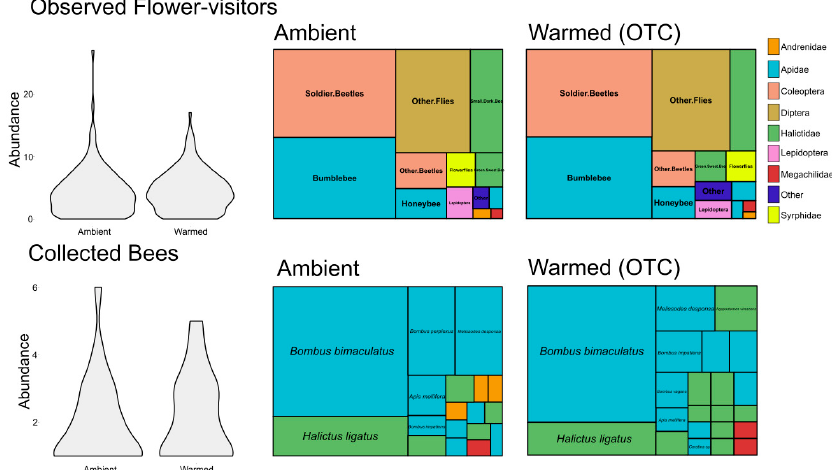
Figure 3. Violin plots and treemaps showing the relative abundances and composition of different morphotypes in observed flower-visiting insects ( top ) and the species of collected bees ( bottom ), as well as a comparison of the ambient ( left ) and warmed ( right ) treatments. The violin plots illustrate the non-normal distributions of the abundance data. Colours refer to the order or family of the insects.